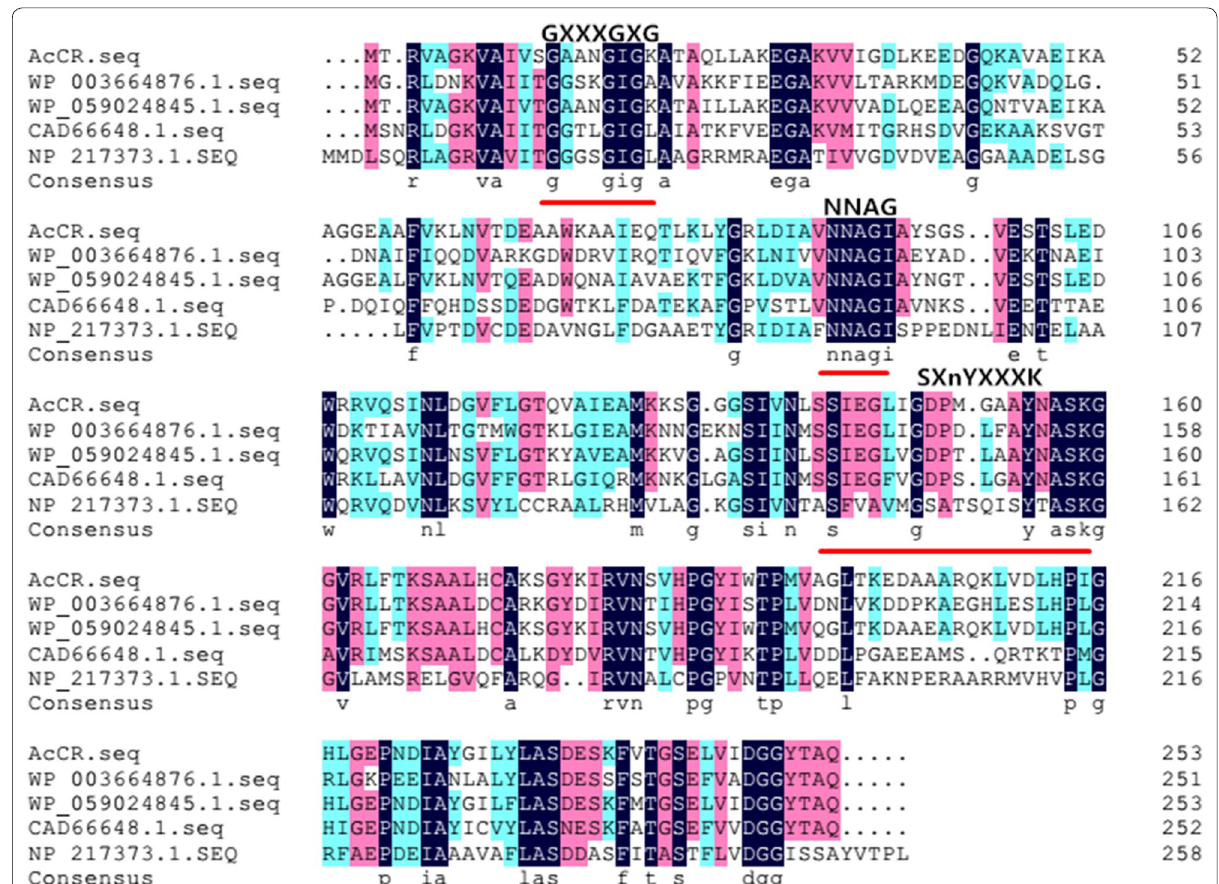
Fig. 1 Alignment of multiple deduced amino acid sequences of AcCR and carbonyl reductases from other